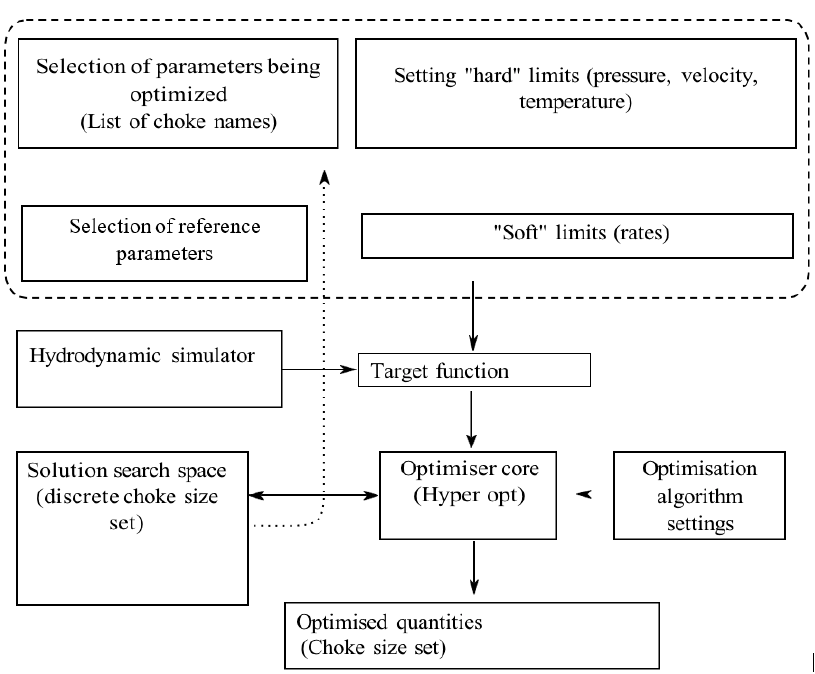
Figure 2. Diagram of the optimization of the well process conditions.